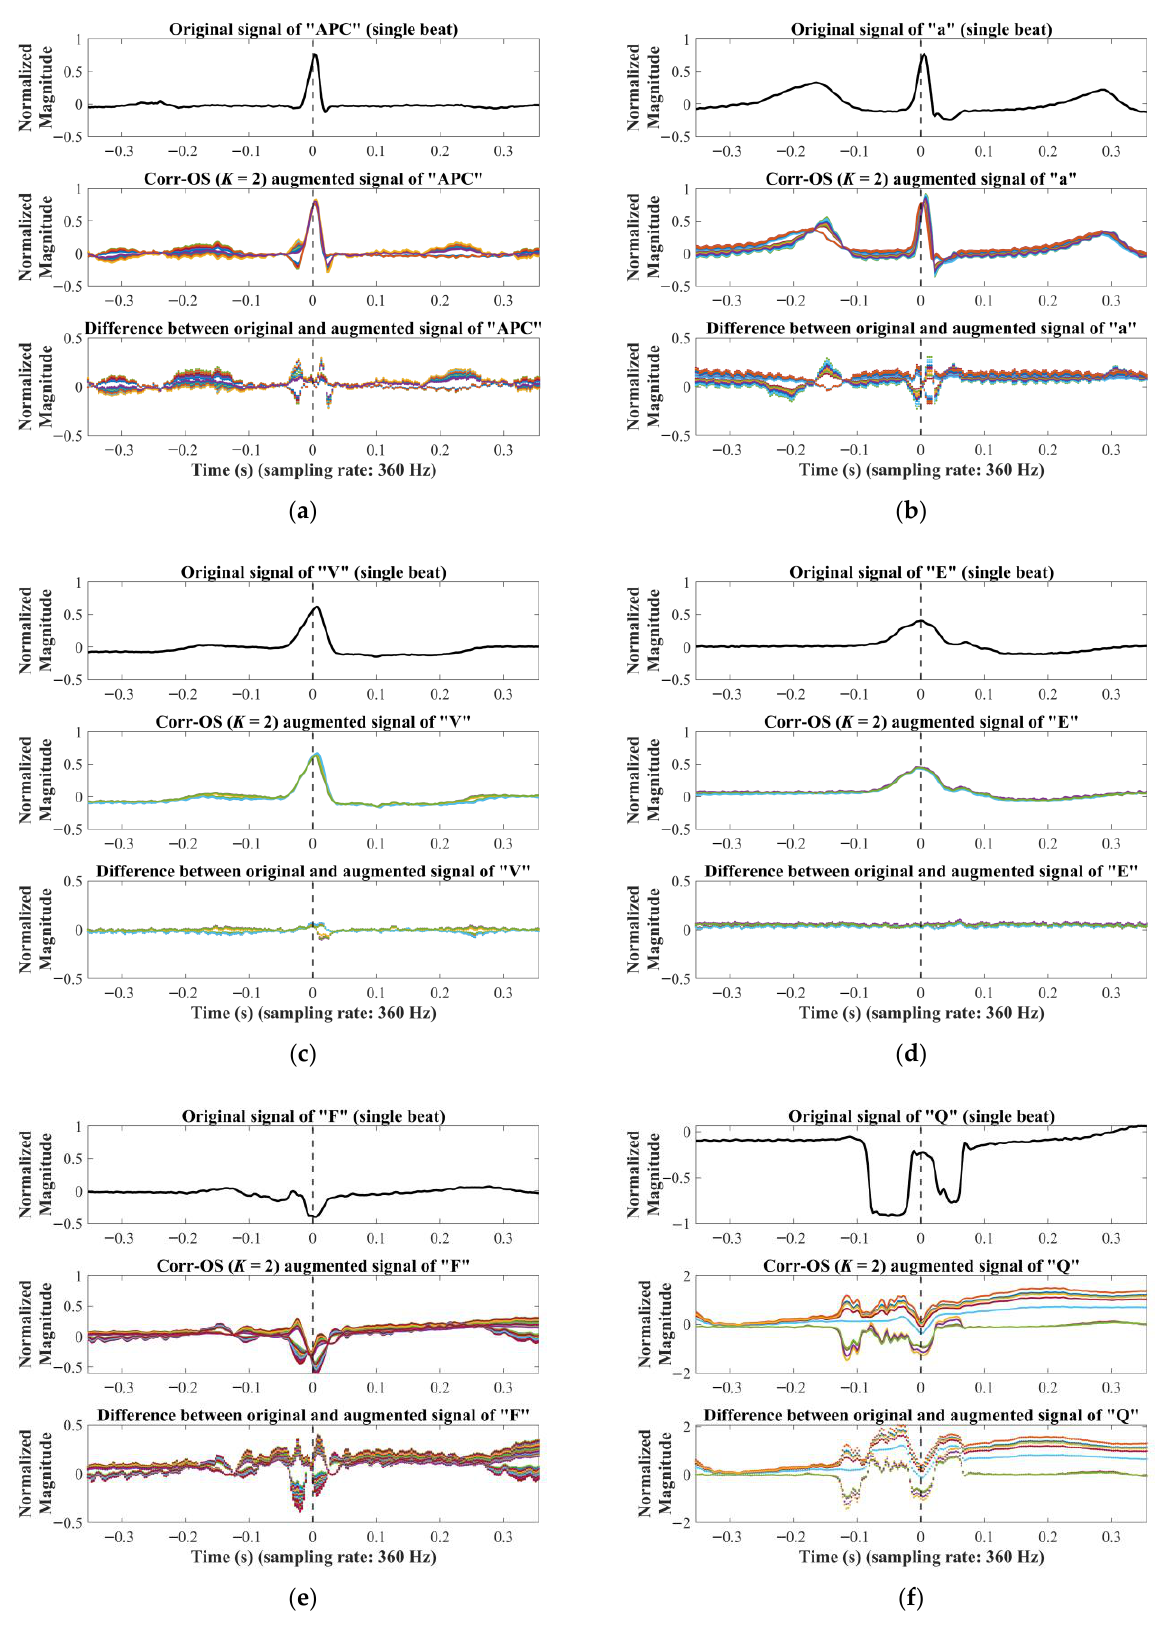
Figure A6. Differences between native and augmented ECG segments generated by Corr-OS ( K = 2) of ( a ) symbol A, ( b ) symbol a, ( c ) symbol V, ( d ) symbol E, ( e ) symbol F, and ( f ) symbol Q (figure adapted from [59]).